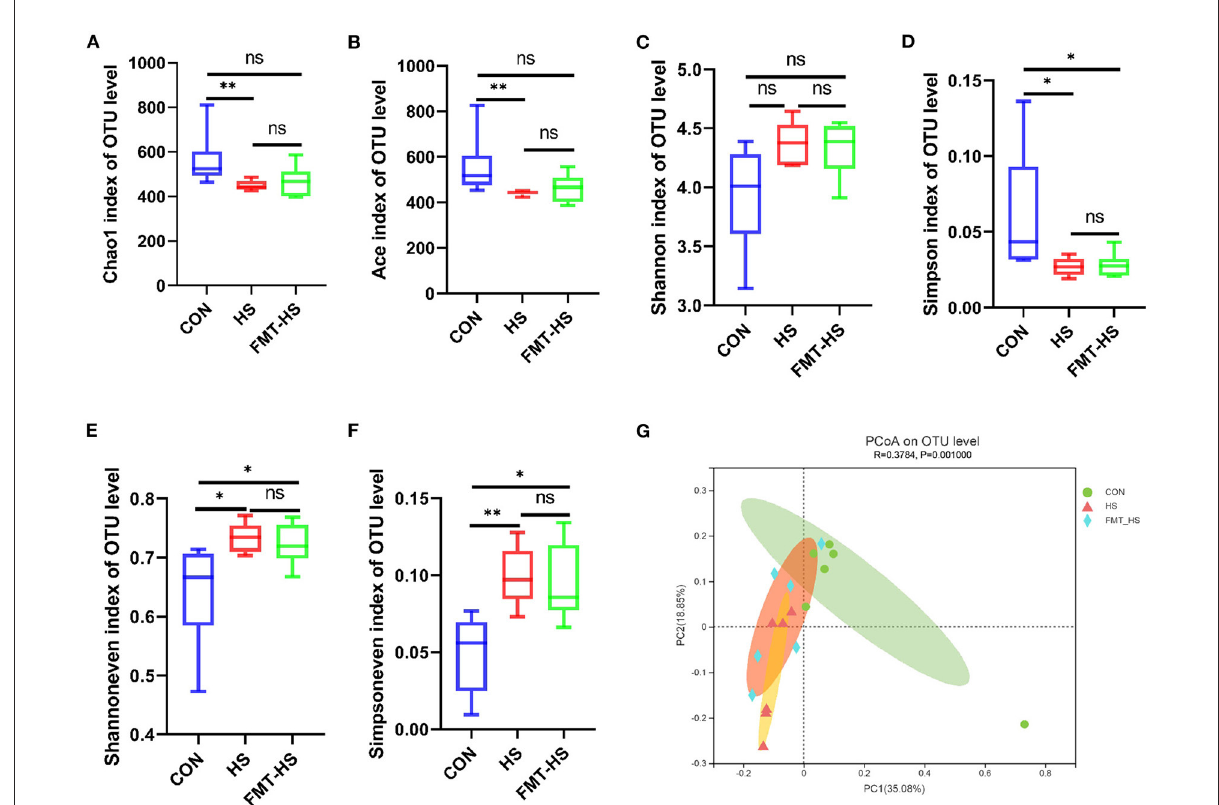
FIGURE2 High salt (HS) dramatically altered gut microbial diversity, and fecal microbiota transplantation was able to transmit these changes. The changes of α -diversity (A–F) . PCoA plot in β -diversity (G). The closer two sample points are, the more similar the composition of the two sample species. Different colored points and shapes indicate samples from different groups. All data are expressed as mean ± standard error (SEM). One-way ANOVA with Tukey post hoc test was conducted. * p < 0.05, ** p < 0.01, ** p < 0.001; ns, no